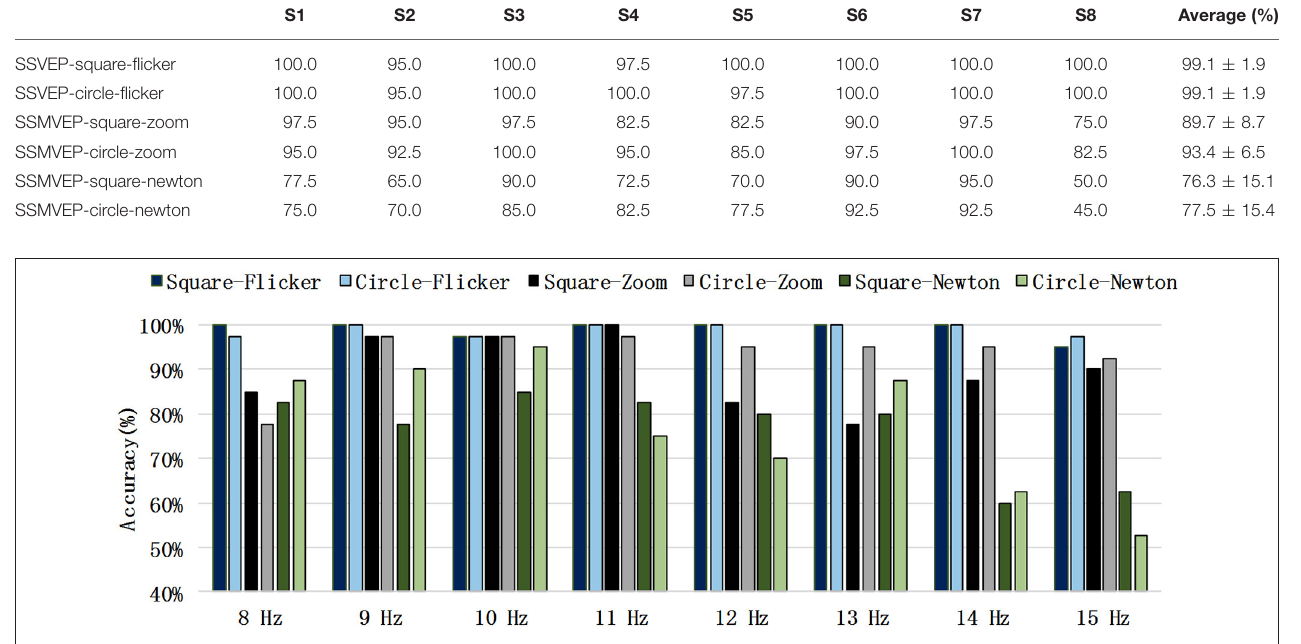
TABLE 1 | Recognition accuracy of the different paradigms.